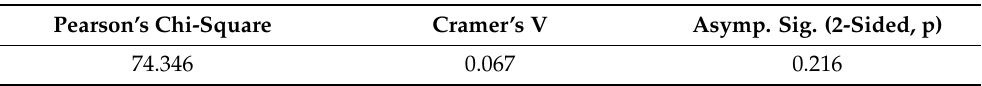
Table 8. The statistical relationship values for relation between the students’ class size and their news reading habits on environmental